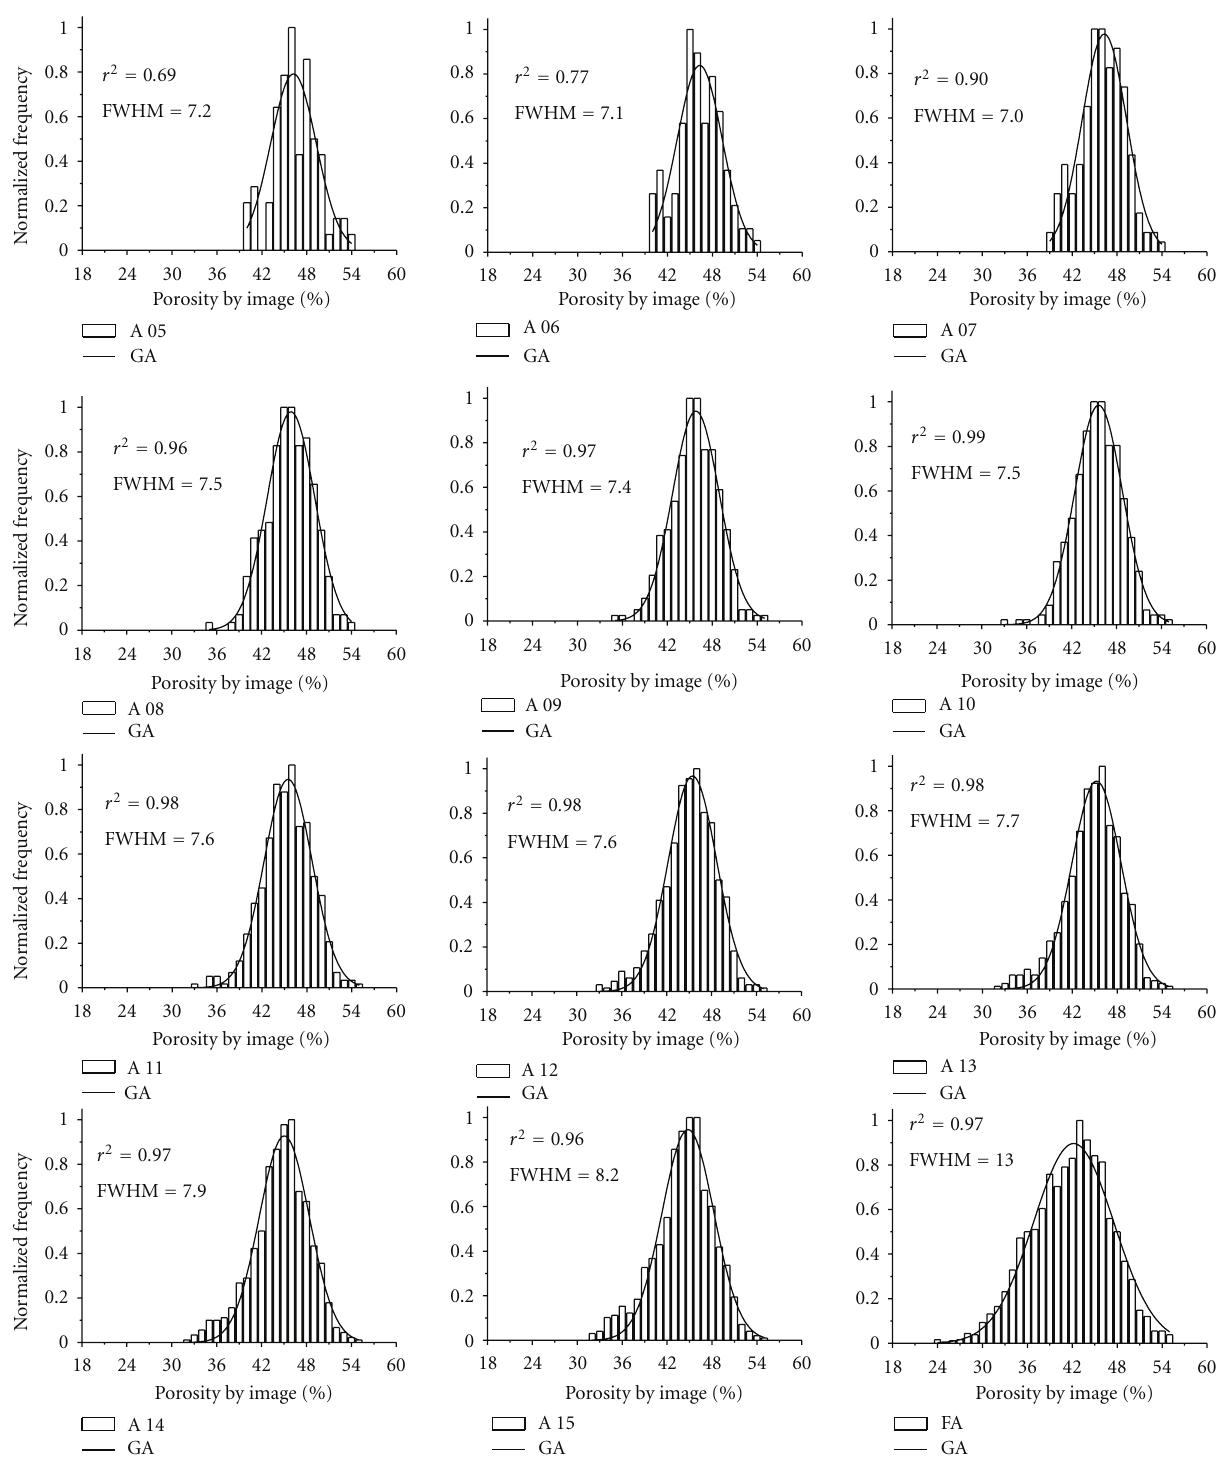
Figure 7: Normalized frequency of the porosity by image (%) from the 5th selected area in the sample 01 (S 01). A 05, A 06, ... , and A 15 correspond to the sequence of quadrangular areas selected in the image and free area (FA). GA represents the Gaussian adjustment, r 2 the coe ffi cient of determination, and FWHM the full width at a half maximum of the